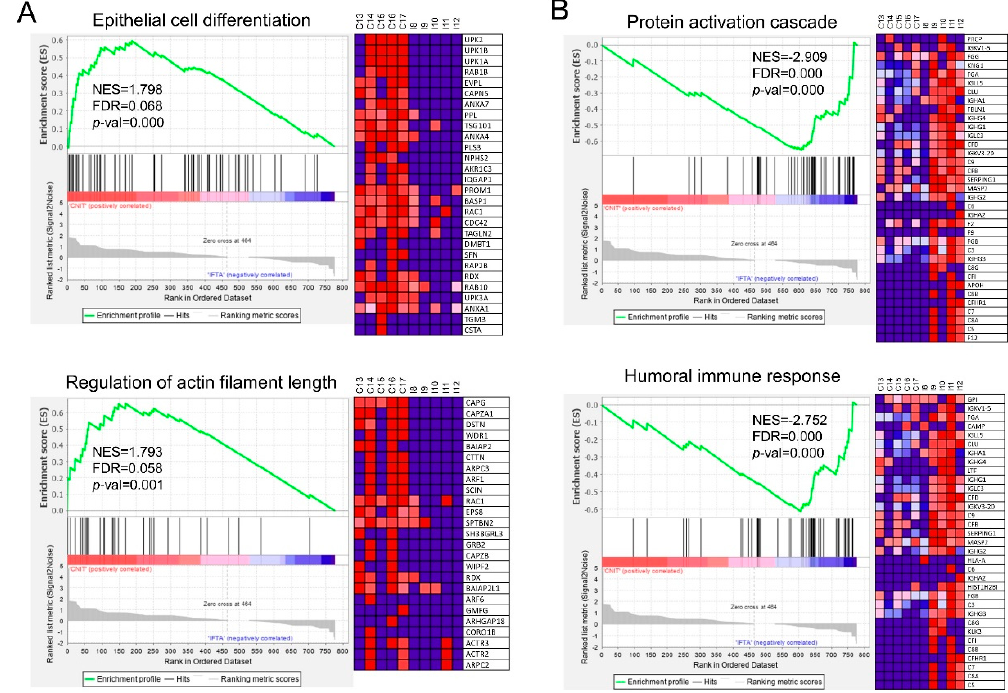
Figure 4. Enrichment plots from GSEA conducted with GO-BP gene sets, each gene accounting for one protein. Statistically significant up-regulation of ( A ) “epithelial cell differentiation” and “regulation of actin filament length” was found in CNIT when compared with IFTA (to the left of the x-axis, positive running enrichment score (ES)). ( B ) “Protein activation cascade” and “humoral immune response” were found up-regulated in IFTA compared to CNIT (to the right of the x-axis, negative ES). Vertical black lines indicate the position of individual genes of the gene set in the ranked list. Heatmap on the right of each plot show the relative expression level of the most up-regulated genes of the gene set (red = high, blue = low). NES, normalized enrichment score; FDR, false discovery rate; p -val, p -value.